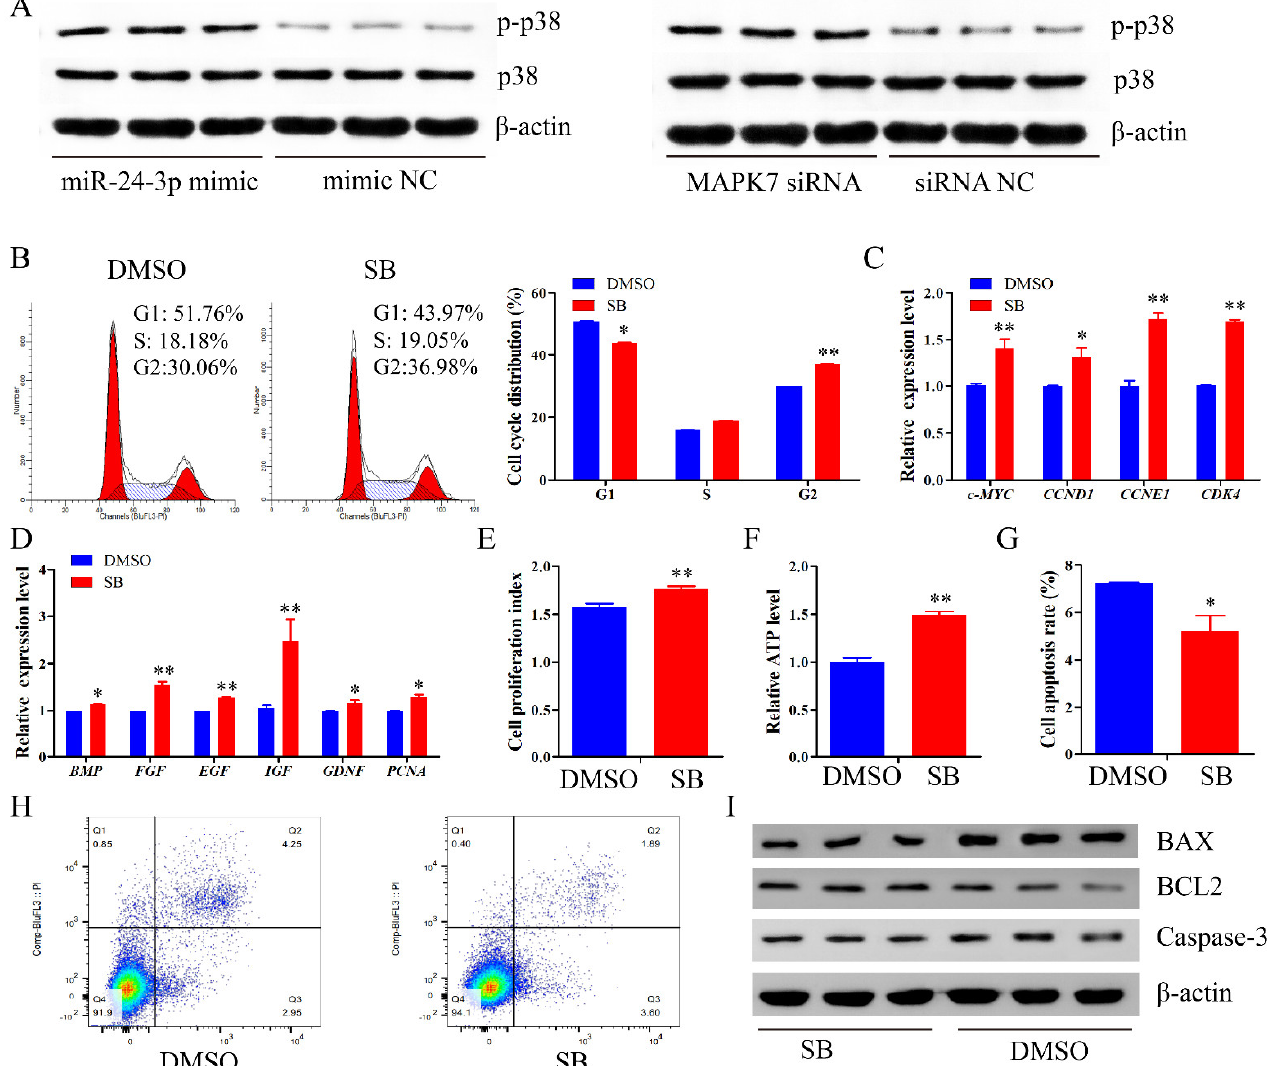
Figure 9. miR-24-3p activates the p38 MAPK signaling pathway. SB202190 (SB) was transfected in immature porcine Sertoli cells to induce the p38 MAPK signaling pathway inhibition. The SB was diluted by the DMSO regent. ( A ) Western blot assay was used to investigate the effect of miR-24-3p overexpression and MAPK7 inhibition on the protein expression of p38 and p-p38. ( B ) The cell cycle distribution was analyzed and then the proportion of cells in G1, S, and G2 phases were counted ( n = 3). ( C , D ) The mRNA expression of cell cycle-related genes ( C ) and cell proliferation marker genes ( D ) was measured using the qRT-PCR assay ( n = 3). The pig-TBP gene was used as the internal control. ( E , F ) CCK-8 ( E ) and EdU incorporation ( F ) assays were used to explore the effect of MAPK7 knockdown on the cell proportion ( n = 3). Representative images of EdU staining are listed. ( G ). The relative ATP level was measured using an ATP assay kit ( n = 3). ( H ) The cell apoptosis rate was investigated using Annexin V-FITC/PI staining assay ( n = 3). ( I ) The protein expression of cell survival-related genes was determined using Western blot assay ( n = 3). The β -actin gene was used as the internal control. Data are presented as the mean ± S.D. * p < 0.05, ** p <